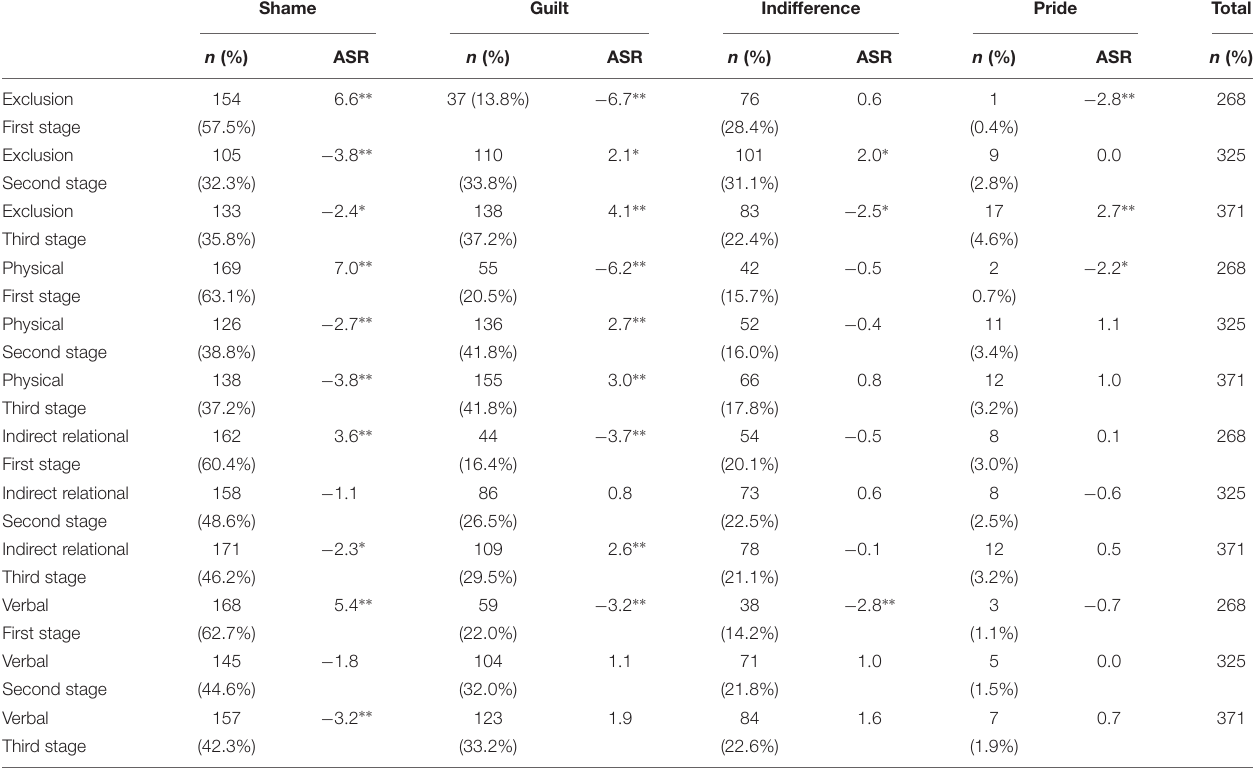
TABLE 3 | Percentages of moral attribution to others and the stage of schooling.